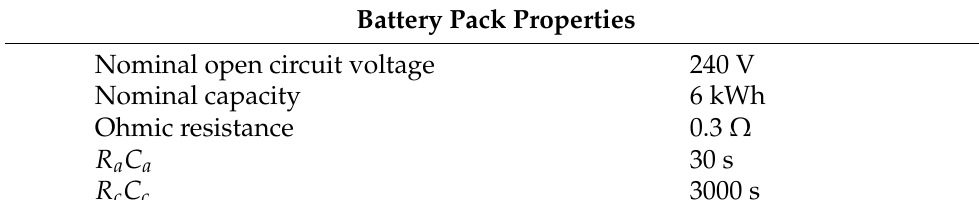
Table 4. Battery pack nominal properties.